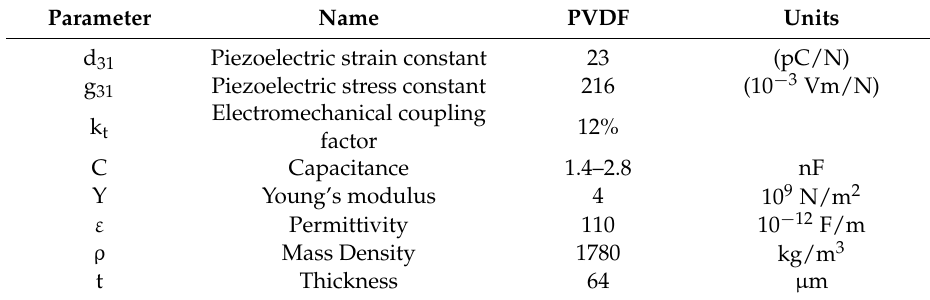
Table 2. PVDF properties.